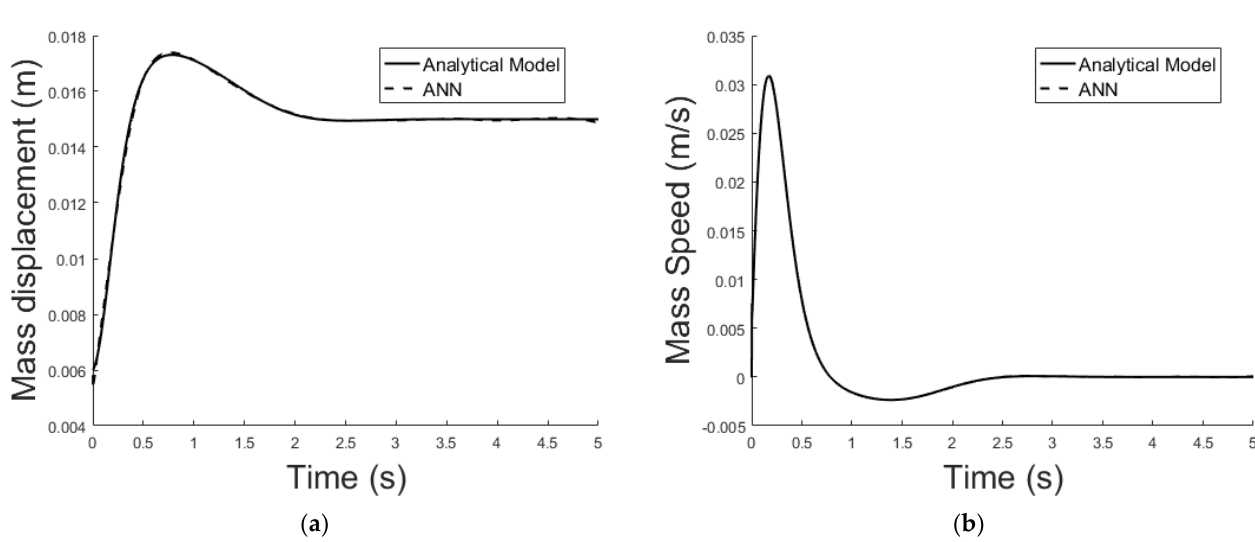
Figure 27. ( a ) Exact model mass displacement versus ANN model mass displacement, equilibrium at x = 0.015 m; ( b ) exact model mass speed versus ANN model mass speed, equilibrium at x = 0.015 m. The dashed line (Figures 22, 24 and 26) represents the ideal case where the ANN simulated results are an exact replica of the targets. The solid line represents the best-fit linear regression line between trained net outputs and targets, which in our case is adja- cent to the ideal case. All cases indicate a good fit, with the scatter manifesting the data points exhibiting a poor fit. R correlates the targets to the simulated net outputs. If R = 1, there is an exact linear relationship between outputs and targets. If R = 0, no linear rela- tionship between outputs and targets can be inferred. All three cases, for different equi- librium points, show a good approximation of the non-linear plant-linear controller-linear observer system output by the ANN (Figures 23, 25 and 27). 6. Conclusions The dynamics of an electro-magneto-mechanical system was investigated in this work. The coupled system simulation was developed and comparatively assessed using different modelling techniques in Matalb/Simulink and Matlab/Simscape. Next, the non- linear state-space problem formulation and the linearization method using partial deriv- atives were presented. The resulting linearized system proved both controllable and ob- servable, yet marginally stable. To stabilize and control the system, pole-placement with full-state feedback is employed. To implement the full-state feedback a state observer is introduced and designed. Using the models developed and the simulation results, an ANN equivalent has been configured and tuned for the non-linear plant-linear controller- linear observer system. The model is flexible and accurate; specifically, it is able to adapt to different equilibrium conditions (equilibrium position was varied in the range 0.005 m and 0.015 m) and compensates satisfactorily for changes in current source input (sinusoi- dal reference input). The system may operate as a contactless displacement sensor or ac- tuator, or in combined mode. In ongoing work, the connection of more than one trans- ducer to the same source will be demonstrated using amplitude modulation. The tuned frequency of each transducer will be defined by assigning different values to the capacitor as shown in Figure 1b. Preliminary analysis shows that such transducer arrays can be used in maritime and aerospace applications, where avoiding physical contact is often a sine qua non requirement, to achieve coordinated sensing and actuation of e.g., space struc- tures like in an orbital station to detect and mitigate the vibrational effects of hits by space debris; or in the maritime, for energy harvesting without violating hull integrity with pen- etrations to implement physical contact. Other applications are possible too, especially if